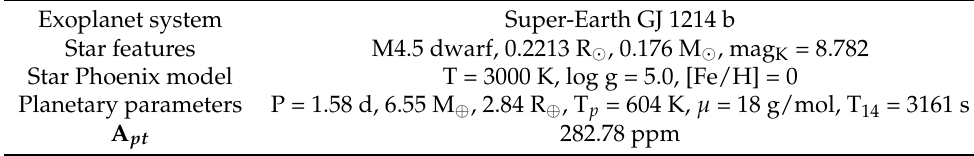
Table 1. Parameters of GJ 1214 b exoplanet system.